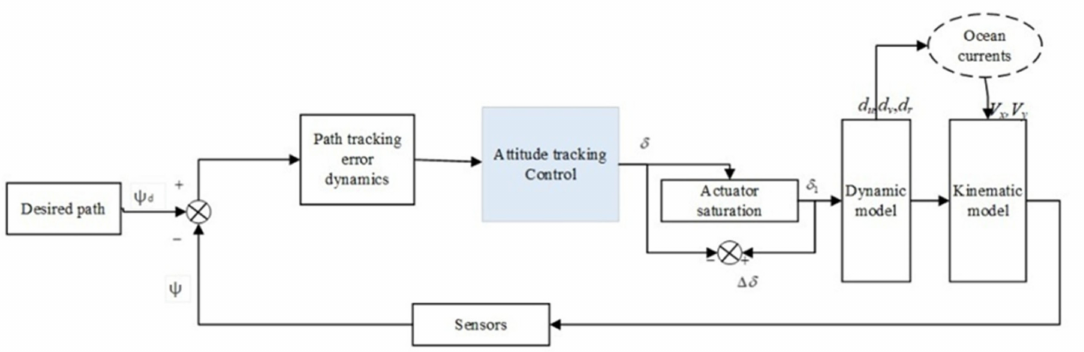
Figure 2. The path tracking control system for AUV in the horizontal